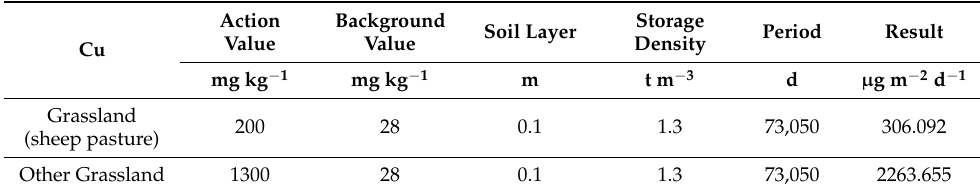
Table 15. Input data and result of the calculation of the precipitation-limiting value for copper in grassland areas.